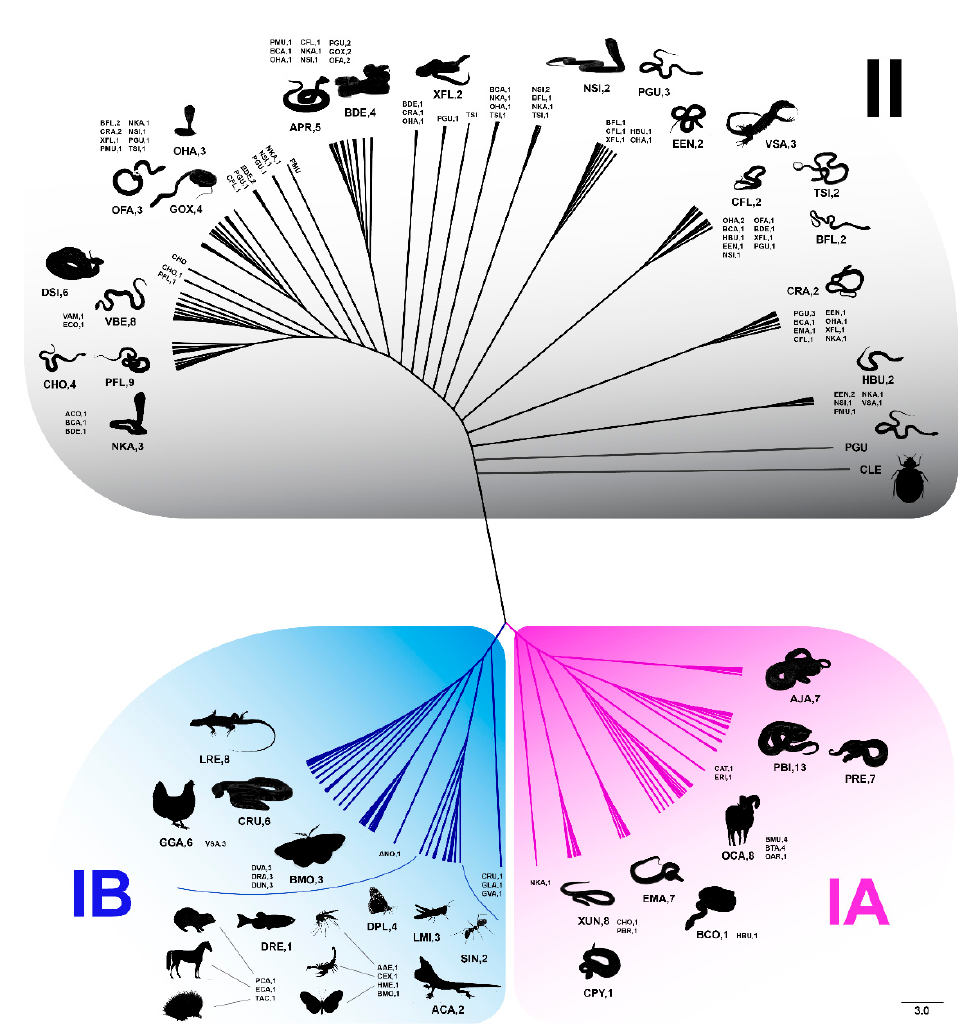
Figure 1. Phylogenetic relationships of Bov-B LINE retrotransposon sequences among eight snake families and outgroups inferred using maximum likelihood analysis. A colored line indicates different groups (Bov-B group I (with subgroups IA and IB) and group II). Bov-B LINE retrotransposon sequences of the snake lineages included Henophidian snakes (Cylindrophidae, Boidae, and Pythonidae families), Caenophidian snakes (Acrochordidae, Viperidae, Homalopsidae, Elapidae, and Colubridae families), and outgroups.